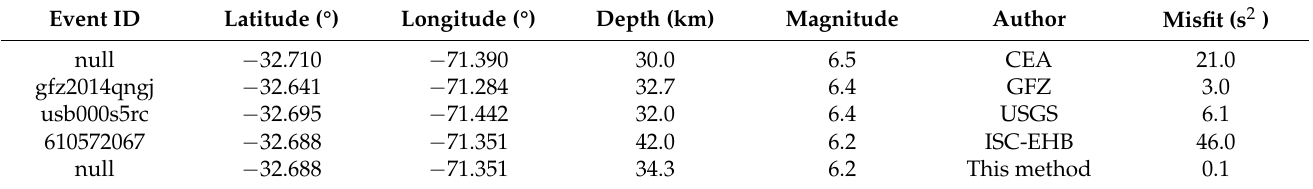
Table 1. The result and comparison for the shallow event occurred on 08/23/2014, Mw 6.1,